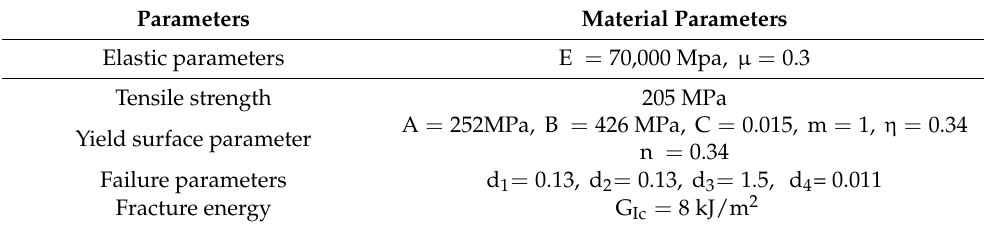
Table 4. 6061 aluminium alloy used Johnson–Cook model parameters [16,45].